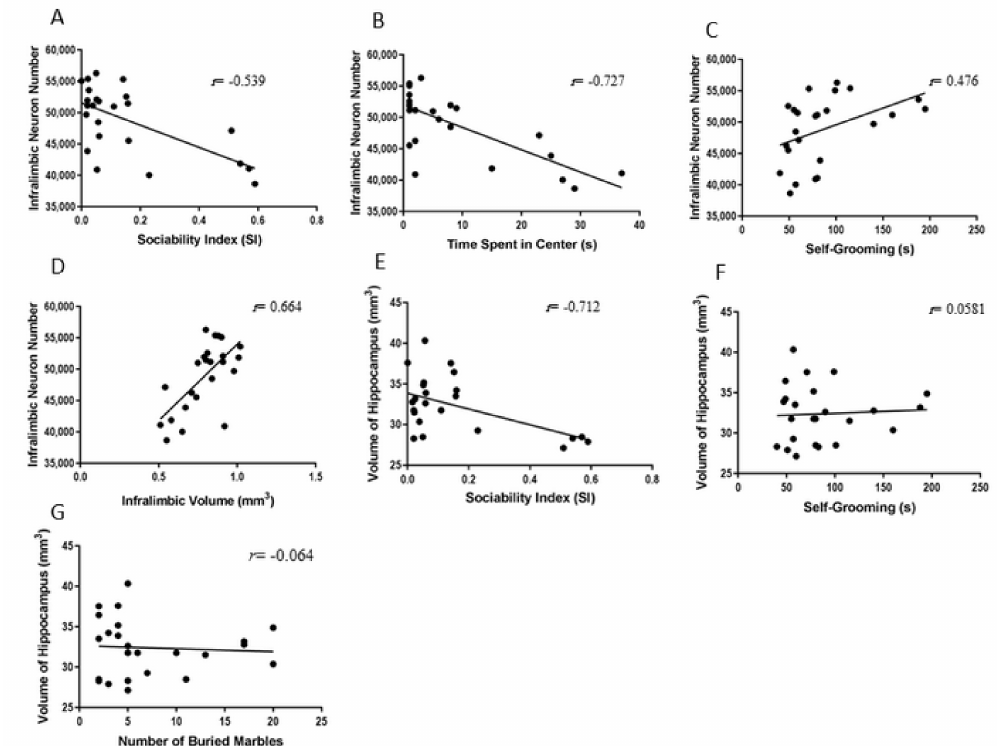
Figure 8. Significant negative correlations between number of the neurons in the infra-limbic area and social index and time spent in centre of the open field ( r = − 0.539, p = 0.007 and r = − 0.727, p < 0.001) ( A , B ). Significant positive correlation between neuron number in the infra-limbic and self-grooming ( r = 0.476, p = 0.019) ( C ) and infra-limbic volume ( r = 0.664, p < 0.001) ( D ). Significant negative correlation between volume of the hippocampus and sociability index ( r = − 0.712, p < 0.001) ( E ). No significant correlation between repetitive behaviours (marble burying and self-grooming) and hippocampus volume ( F , G ) were observed ( p >